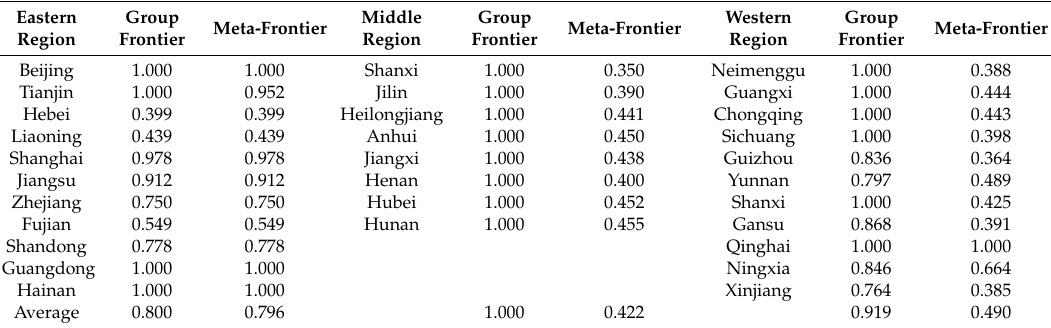
Table 3. Average TFEE of provinces under the two different frontiers.